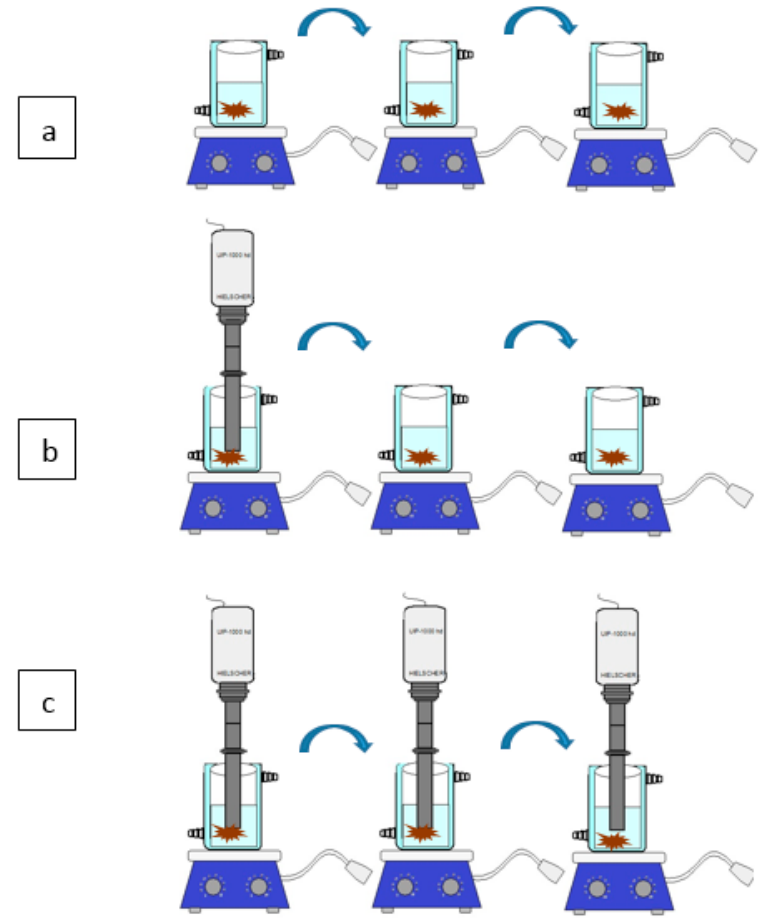
Figure 13. Multistage cross-current extraction; ( a ) multistage conventional maceration; ( b ) multistage extraction combination of ( a , c ); ( c ) multistage ultrasound assisted maceration.